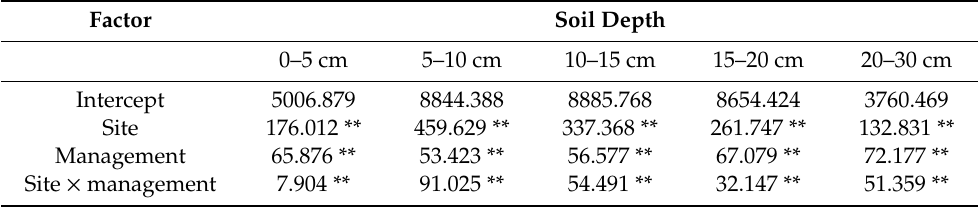
Figure 1. OC-stock in the topsoil (0–30 cm soil depth) of ( a ) 4-year old (Cahnsdorf); ( b ) 15-year old (Gülzow) and ( c ) former (Vipperow) short rotation coppice (SRC), former SRC (FRC) and adjacent reference sites with cereals or manure grasses (REF). Table 2. Test values of the F distribution from the analyses of variance (ANOVA) of the C-stocks from three study sites in Germany (poplar in short rotation coppice vs. annual arable